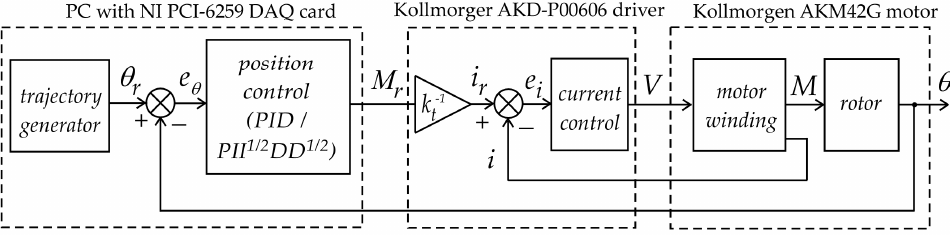
Figure 12. Overall control scheme of the experimental layout.